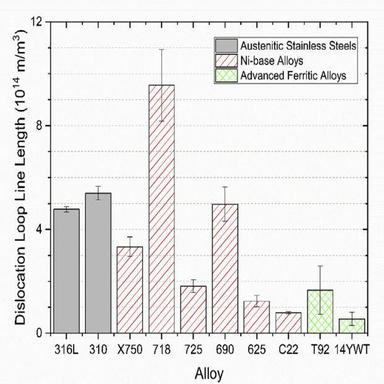
Dislocation loop line length induced by dual ion irradiation (400 C, 150 dpa, ~13 appm He/dpa) of austenitic stainless steels (solid grey), Ni-base alloys (striped red), and advanced ferritic alloys (cross-hatched green). (For interpretation of the references to colour in this figure legend, the reader is referred to the Web version of this article.)